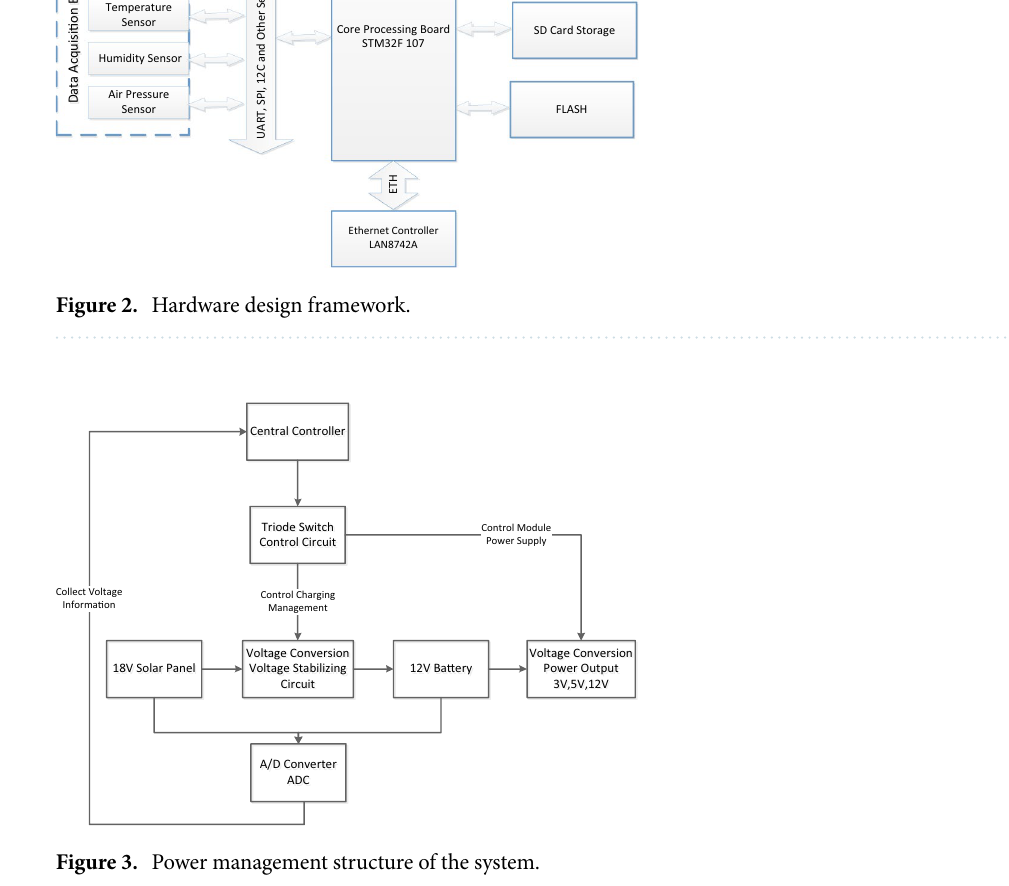
Figure 3. Power management structure of the